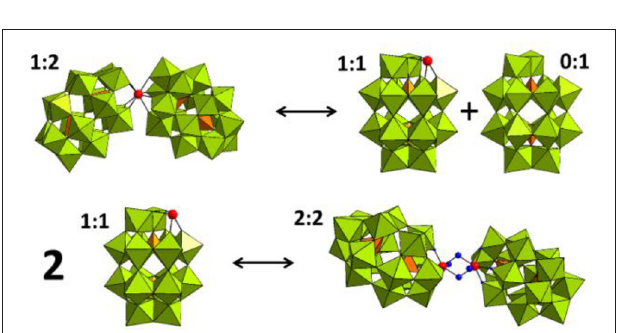
FIGURE 3 | Equilibria between the 1:2, 1:1, and 2:2 species of the Hf(IV)-substituted Wells-Dawson POM. WO 6 octahedrons are represented in olive green, PO 4 tetrahedrons—in orange, and the Hf(IV) centers is represented as a red spheres.